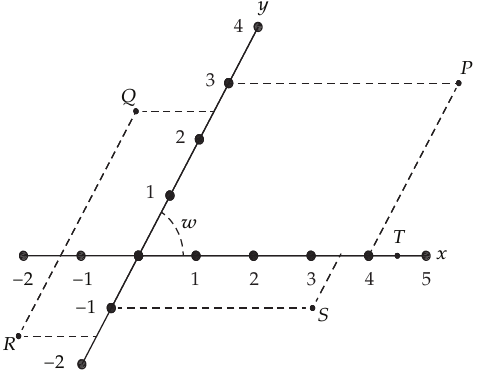
Figure 9: Points in an oblique coordinate